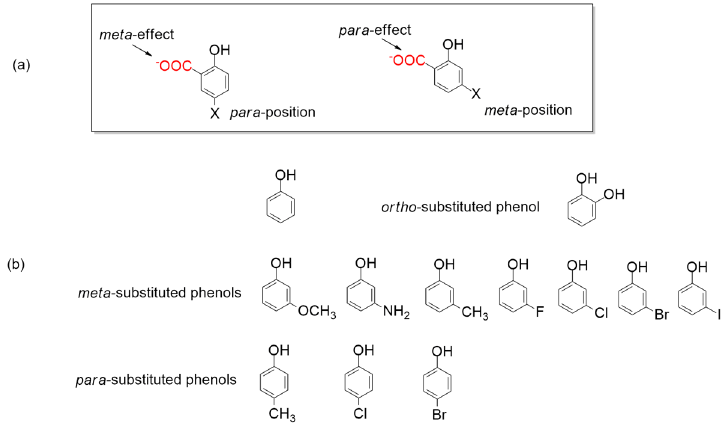
Figure 18. ( a ) The meta - or para -effect of the X-substituents was referred to the carboxylic directing group; ( b ) ortho -, meta -, and para -substituted phenols used in LFERs study.